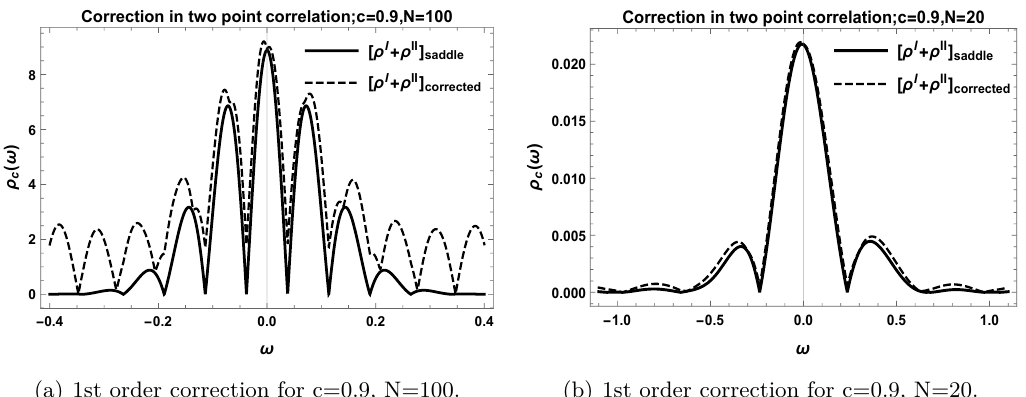
Figure 6 . Correlation function w.r.t. ω for different dimension of Matrix(N) and effect of correction from second term of eq.